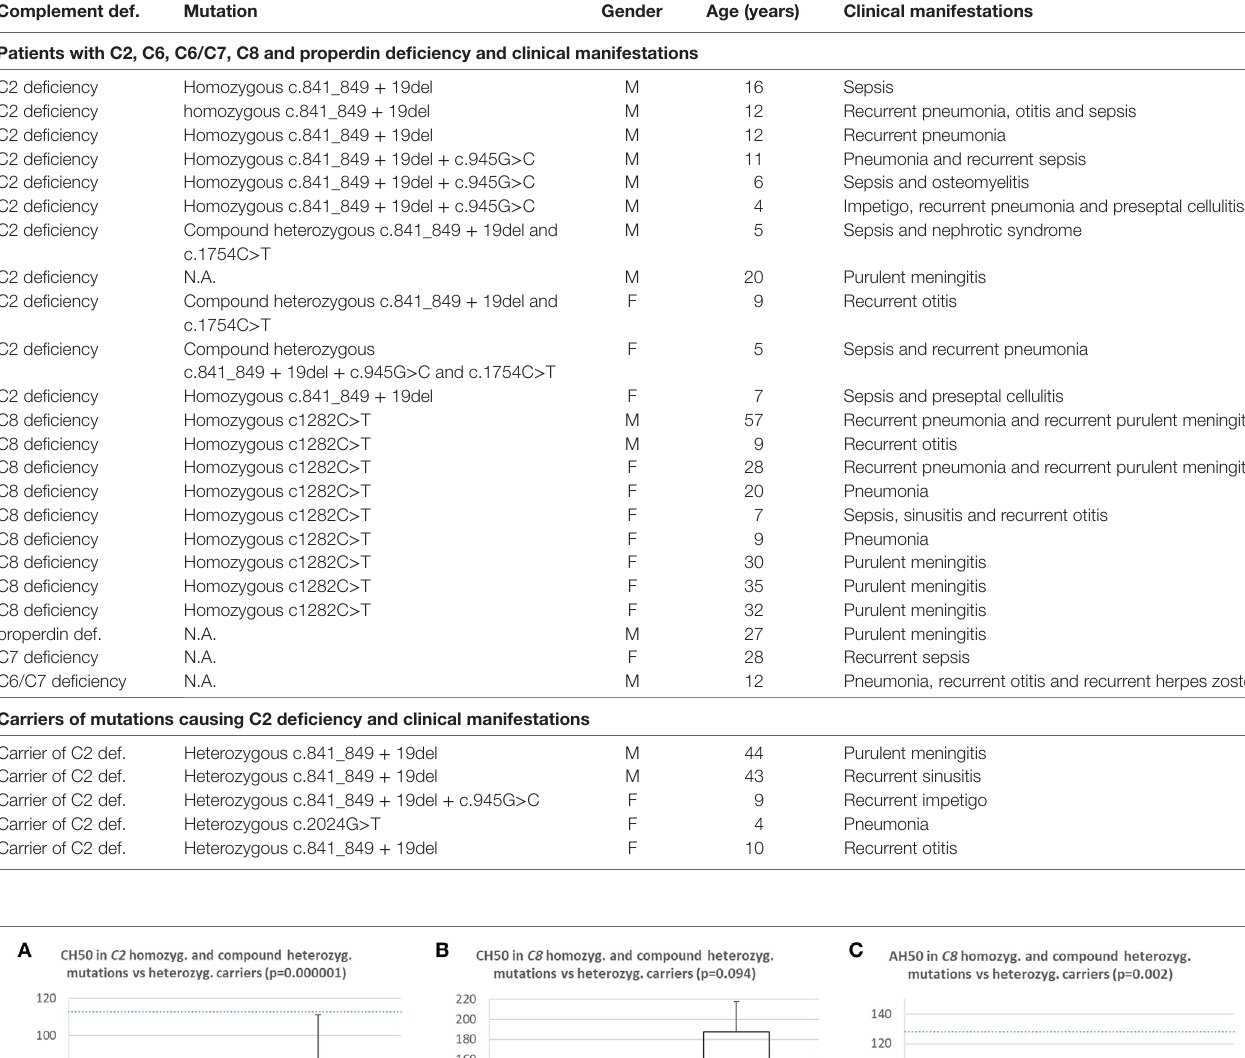
TaBle 1 | Clinical manifestations and genetic defects in symptomatic patients and carriers of complement deficiency excluding hereditary angioedema. complement def. Mutation gender age (years) clinical manifestations Patients with c2, c6, c6/c7, c8 and properdin deficiency and clinical manifestations